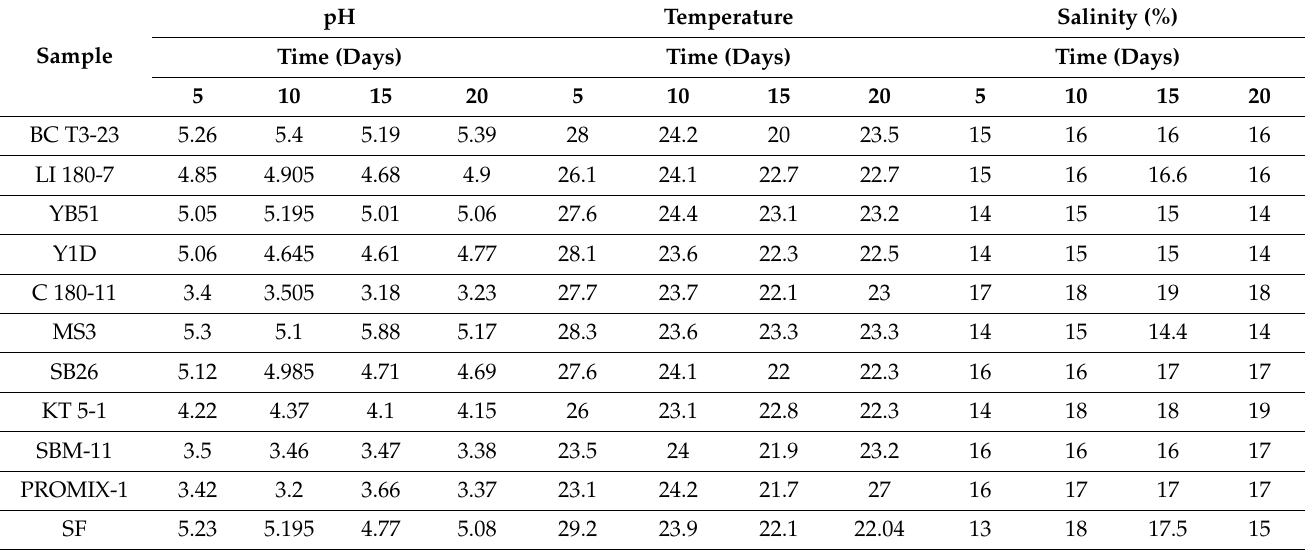
Table 5. Evolution of chemical–physical parameters during the fermentation of Jellyfish paste